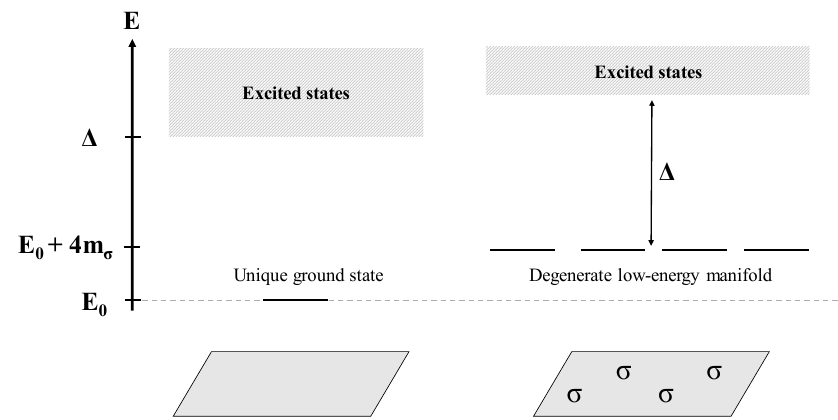
Figure 3: When an intrinsically topologically ordered state is placed on a surface of trivial topology and no anyons are present, the ground state at some energy E is unique and sepa- 0 rated from excited states by an energy gap ∆ . In the presence of non-Abelian anyons that we denote by σ , the lowest energy state exhibits degeneracy that depends on the type of anyons present (e.g. four-fold degeneracy if four σ anyons of the Ising model are present, as we dis- cuss soon in Section 3.4). Since anyons are massive excitations in intrinsically topologically ordered states, this degenerate manifold appears at some higher energy than the ground state + 4 m in the absence of anyons (e.g. at energy E σ when each Ising anyon has mass m σ ), but it 0 is still separated from excited states by the spectral gap ∆ . Qualitatively similar picture applies also to SPT states with defects, such as a topological p -wave superconductor with vortices. In this case each σ denotes a massless Majorana modes bound to a vortex, but each vortex is still carries some mass m σ